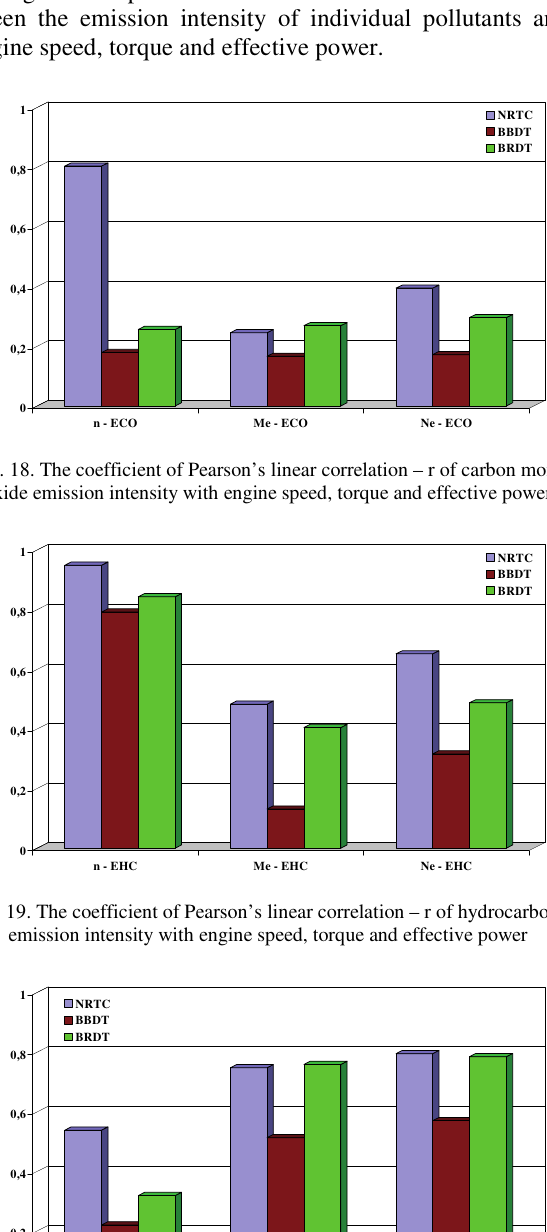
Fig. 17. The coefficient of Pearson’s linear correlation – r between engine effective power and pollutant emission intensity in individual test